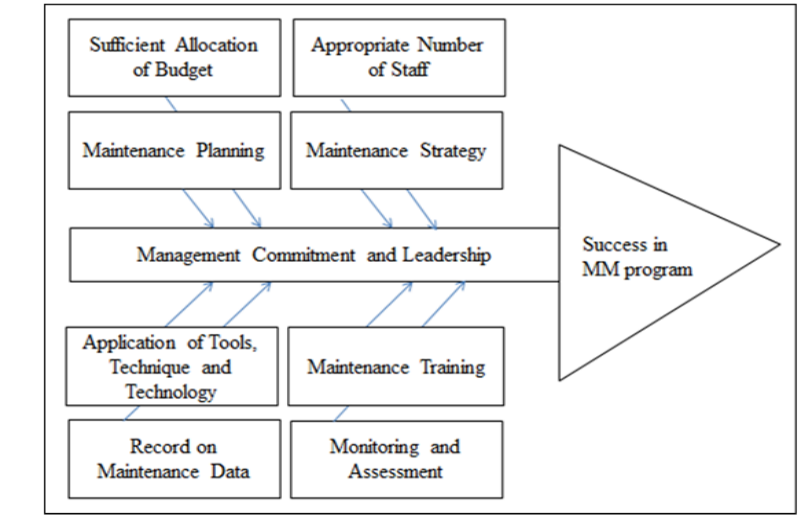
Figure 1. MM Framework I - adapted from: [26,